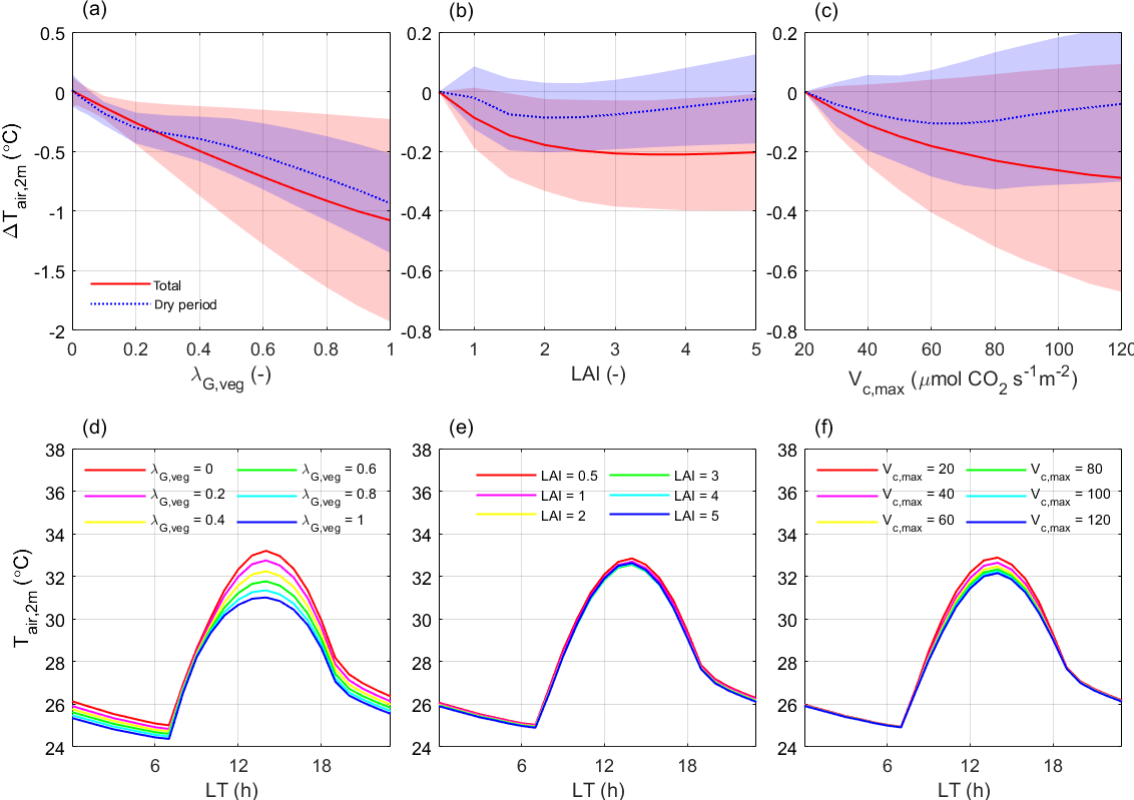
Figure 11. Change in 2m canopy layer air temperature ( T air,2m ) caused by the change in vegetated ground cover fraction ( λ G,veg ), leaf area index (LAI), and maximum RuBisCO capacity ( V c,max ) in Telok Kurau, Singapore. (a–c) Mean air temperature change considering all weather conditions (solid line) and mean air temperature change during the dry period (15 February–16 March 2014) (dotted line) with respect to the baseline cases ± 1 standard deviation (shaded area). The subplots (d–f) show long-term mean daily cycle of air temperature for different values of (d) λ G,veg , (e) LAI, and (f) V c,max considering all weather